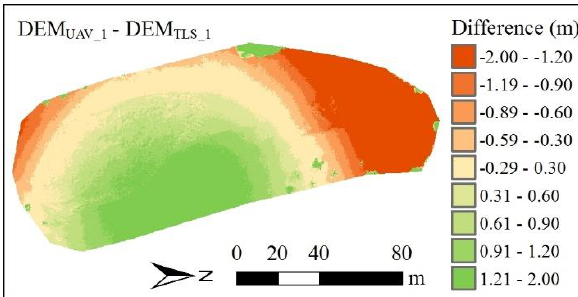
Figure 4. Difference between TLS- and UAV derived DEMs recorded in October 2014 (mean = 0.04 m; stand. dev. = 1.56